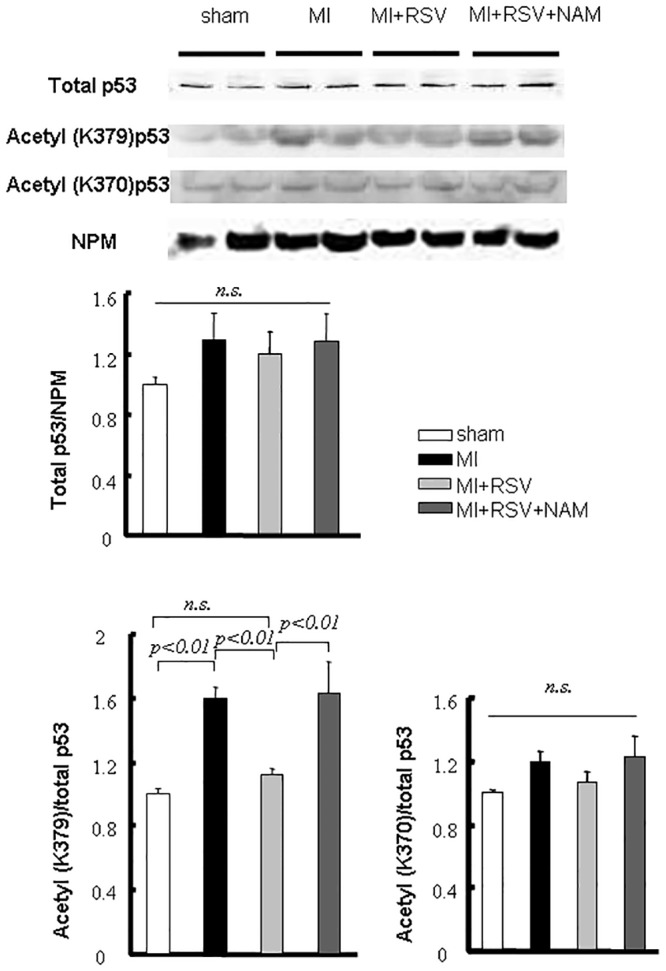
Modulation of p53 caused by RSV.Representative immunoblots and bar graphs of the total p53 and acetyl-p53 (K379 and K370) levels in nuclear extracts (LV). AMI activated p53, and RSV reversed this effect through p53 deacetylation.